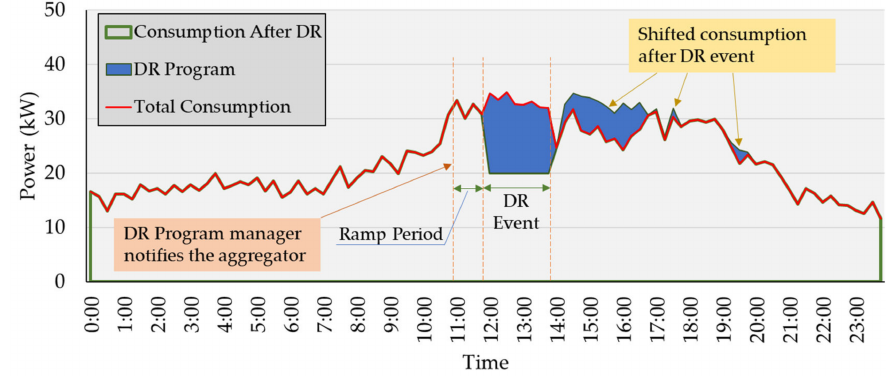
Figure 8. Proposed DR event applied in the aggregator consumption